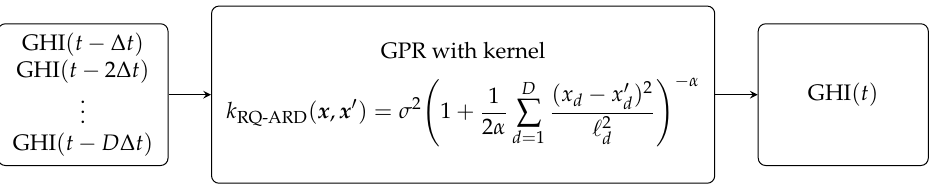
Figure 4. GPR forecasting model based on the RQ-ARD kernel k RQ-ARD . GHI ( t − ∆ t ) , GHI ( t − 2 ∆ t ) , . . . , GHI ( t − D ∆ t ) is the observation set and ∆ t = 10min is the time